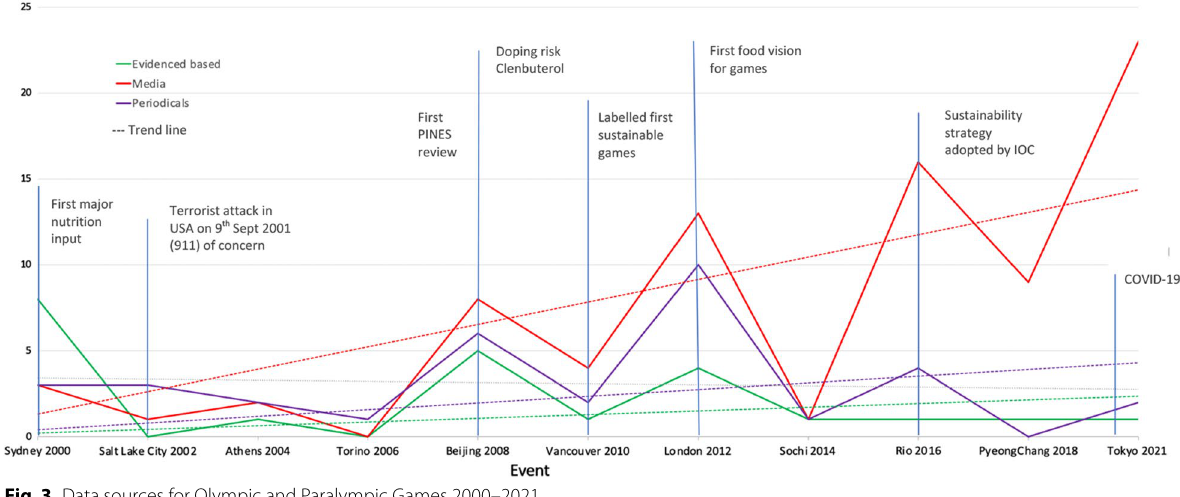
Fig. 3 Data sources for Olympic and Paralympic Games 2000–2021